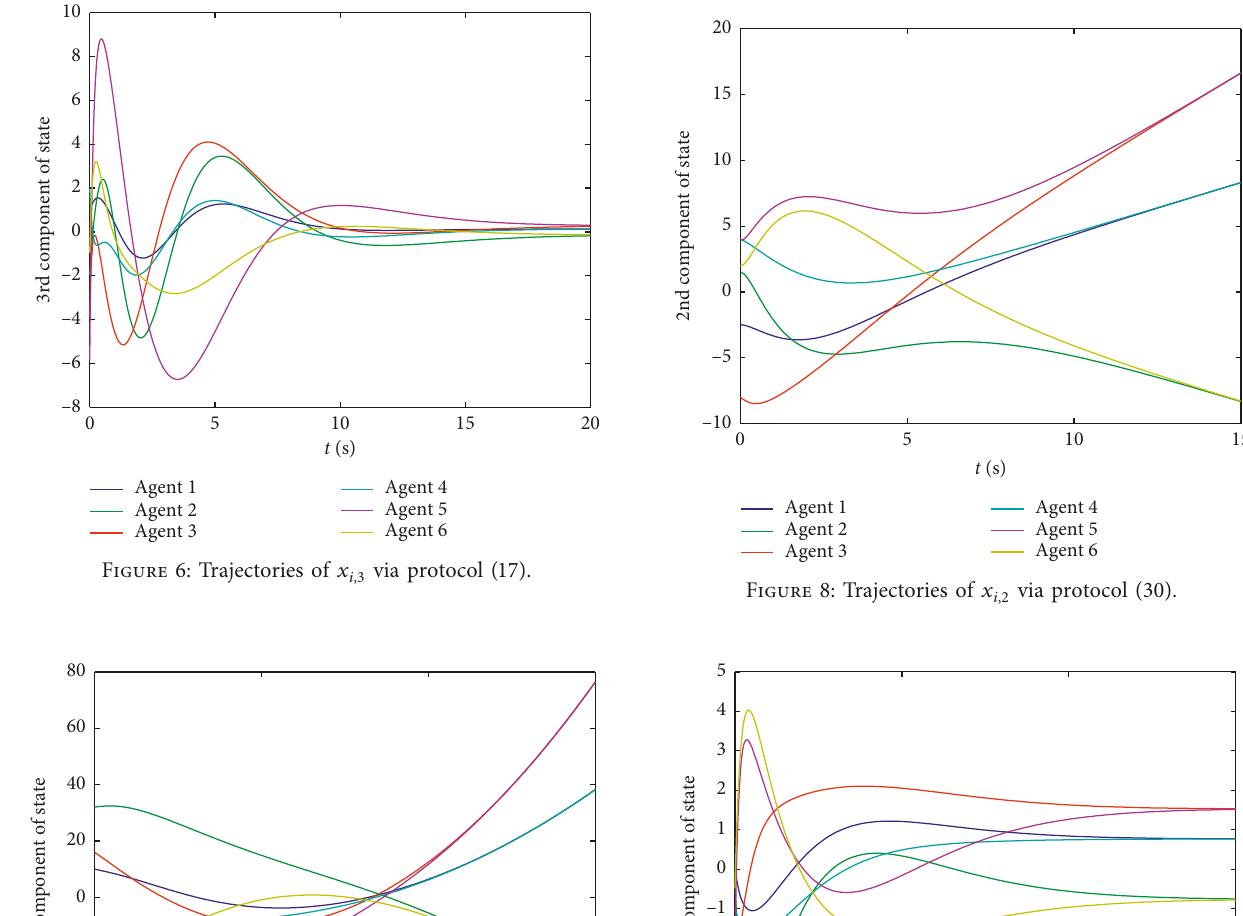
i, 2 via protocol (30).